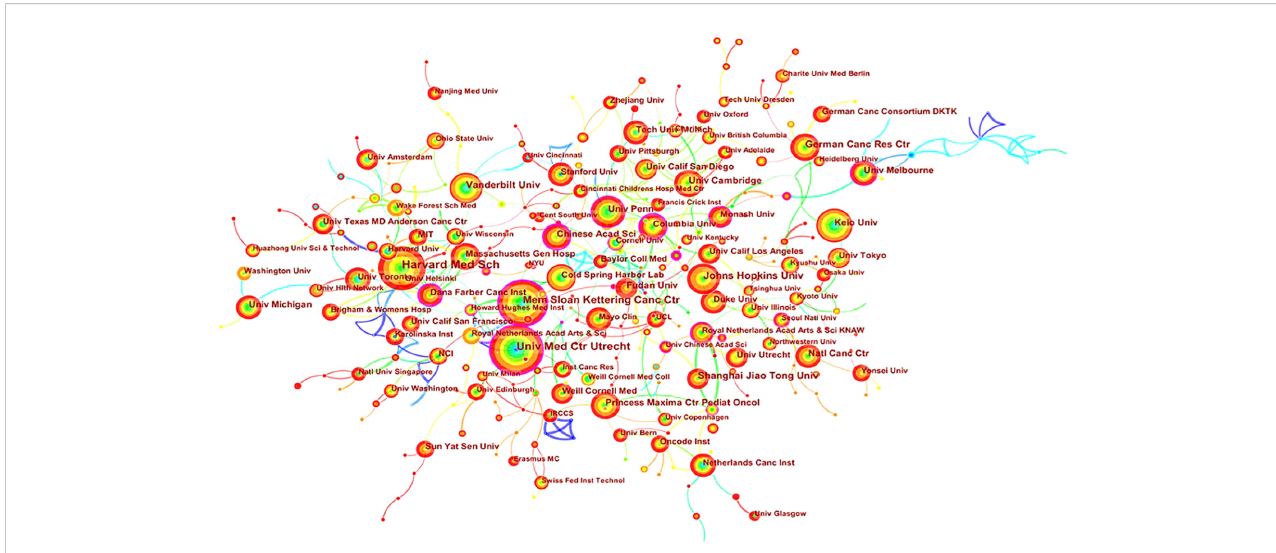
FIGURE 5 Map of cooperation in tumor organoid research. The nodes in Figure 5 represent different institutions, and the size of the nodes represents the number of articles published. The purple ring in the outermost circle indicates a central node, which has a central position in the cooperation between this institution and other institutions. The wired lines indicate cooperation among